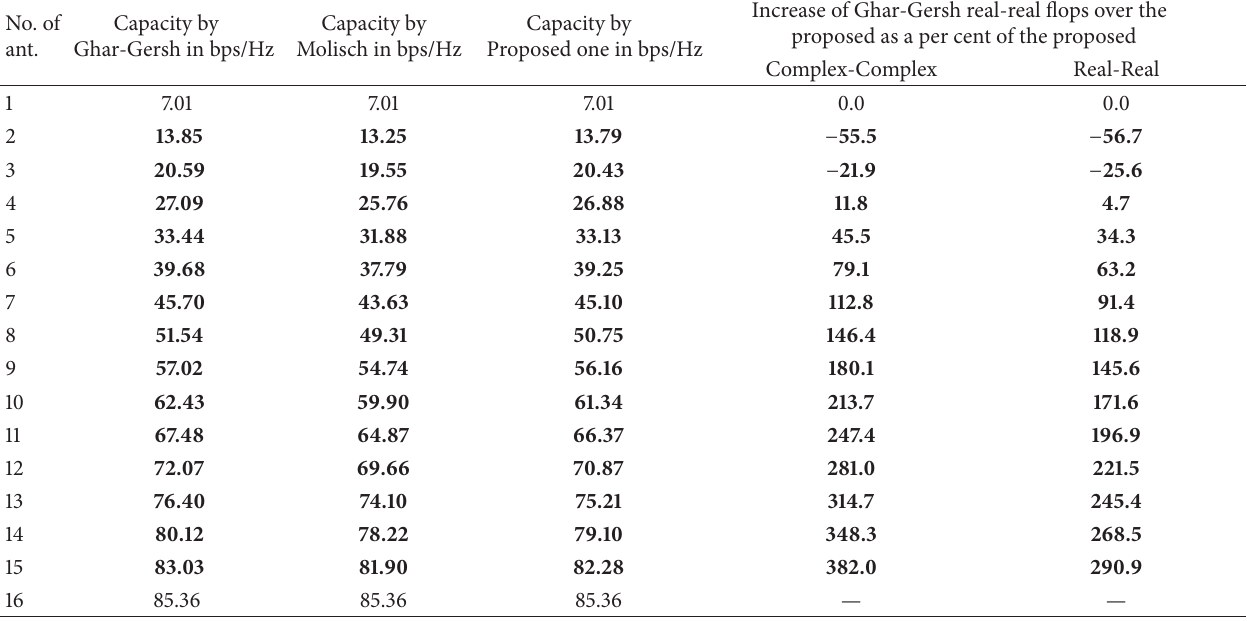
Table 4: Variation of outage capacity with 𝐿 𝑅 for 𝑀 𝑇 = 𝑀 𝑅 = 16 .